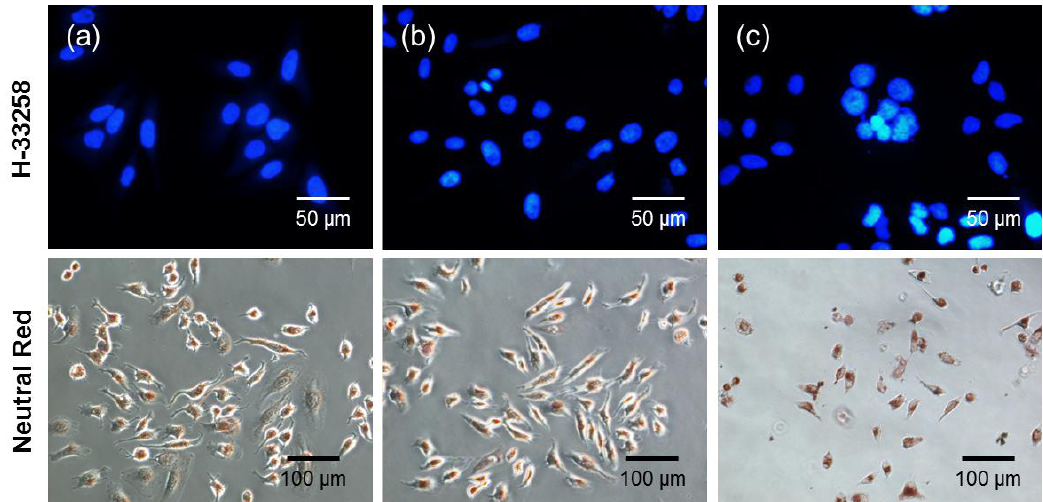
Figure 10. Morphology of HeLa cells stained with neutral red and H-33258 ( a ) before photodynamic treatment (no drug and no light) and after treatment with ( b ) free Ce6 and ( c ) DC (4 μg/mL Ce6), followed by irradiation with a 2.5-J/cm 2 , 671-nm diode laser.